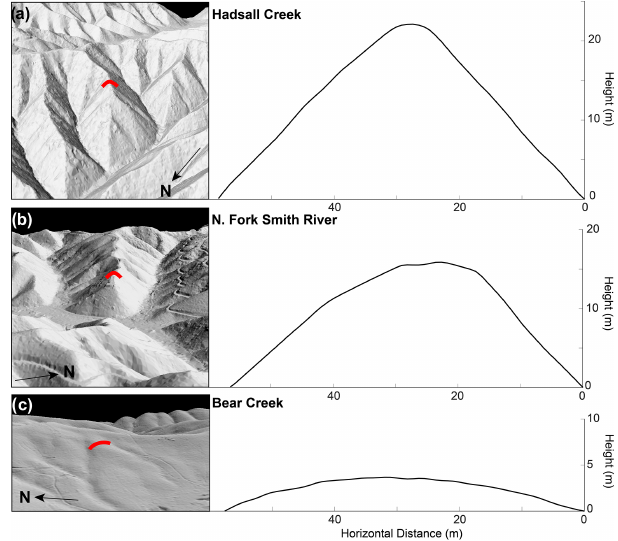
Figure 2. Oregon Coast Range hillslope profiles. Example lidar hillshades of hillslopes from Hadsall Creek (a) , the North Fork Smith River ( b ; NFSR), and Bear Creek (c) . Red lines in hill- shades correspond to the hillslope profiles in right column. Note that hillslope profiles have the same horizontal scale, allowing for clear visualization of the difference in hillslope relief between sites. Each sample hillslope profile corresponds to the representative hill- top in each catchment (yellow lines in Fig. 1). Note that at the rapidly eroding Hadsall Creek and NFSR, the hillslopes have at- tained threshold gradients and are near-planar. C HT , however, still reflects the difference in erosion rate between